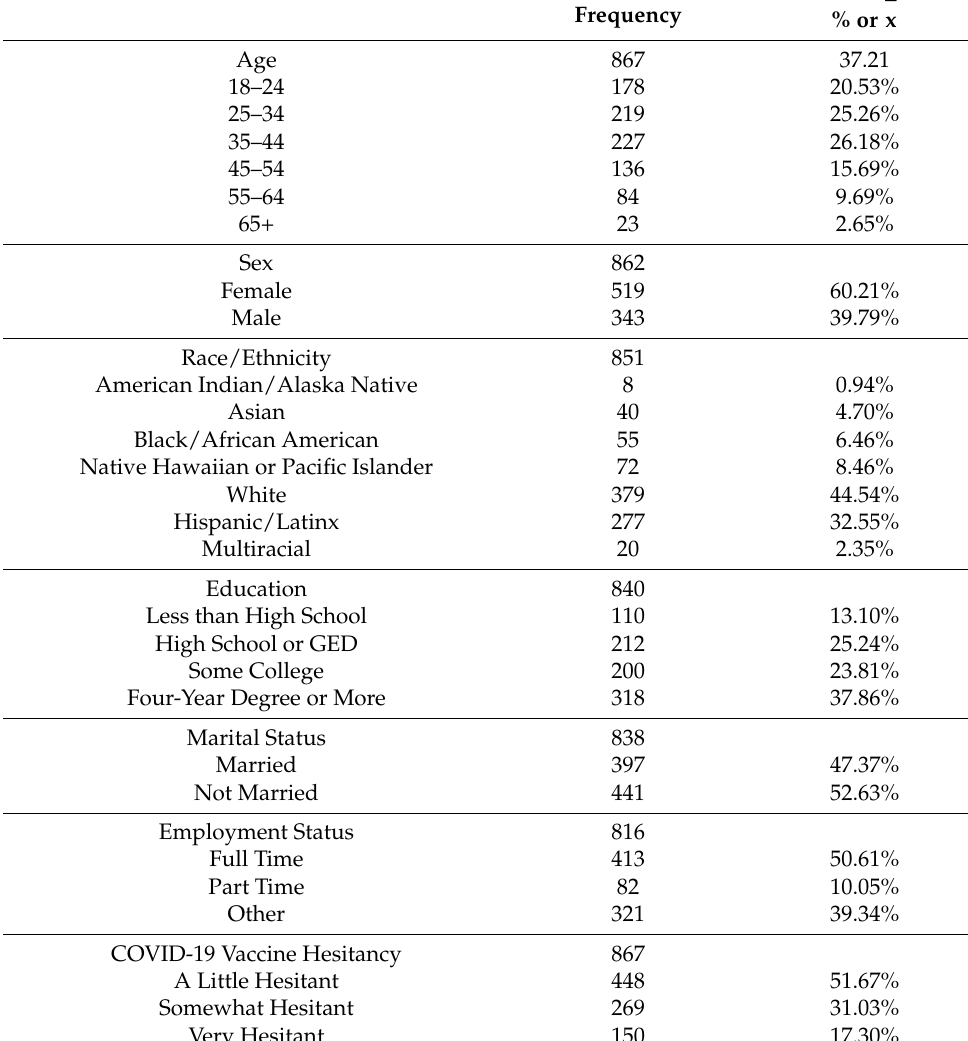
Table 1. Descriptive characteristics of recently vaccinated Arkansans ( n =